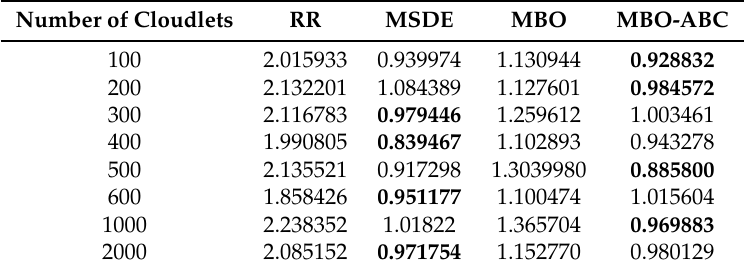
Table 13. Comparative analysis for the DI indicator (best results from each category of test instances are marked